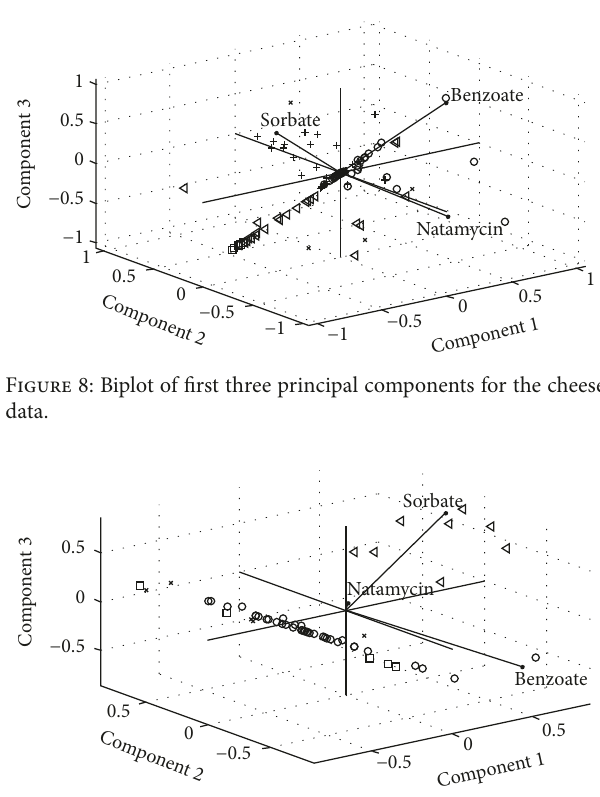
Figure 9: Biplot of first three principal components for the yogurt